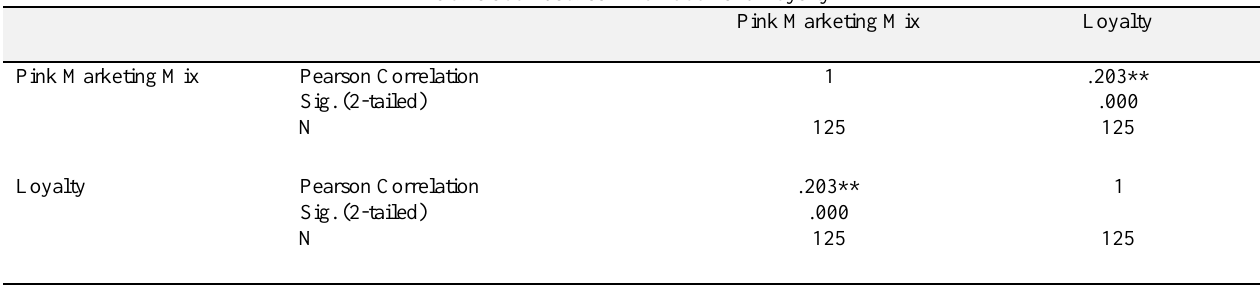
Correlation between Promotion and Loyalty